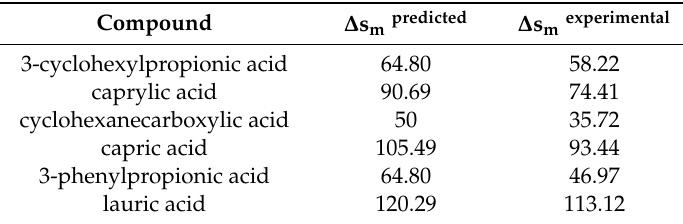
Table 3. Comparison of predicted ∆ s m predicted and experimental ∆ s m experimental melting entropy of monocarboxylic acids.